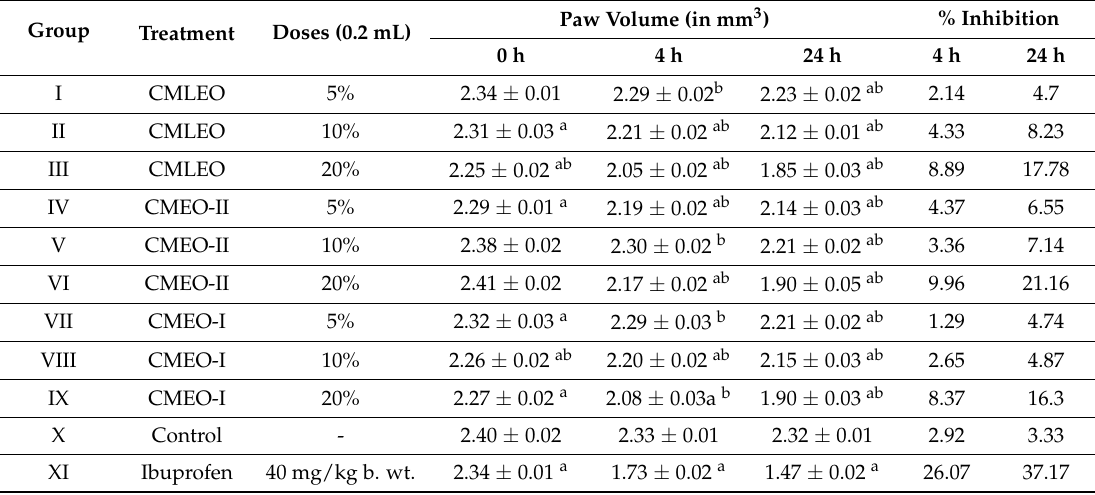
Table 3. Effect of essential oils from C. macrophylla on carrageenan-induced paws